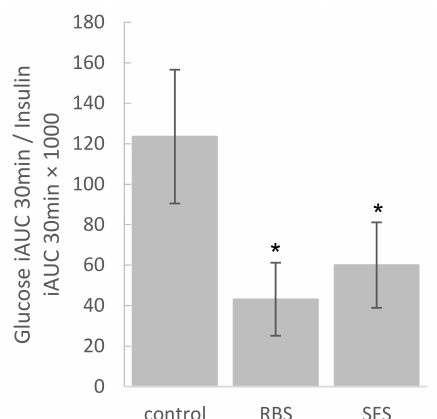
Figure 3. Ratio glucose/insulin during first 30 min for the reference and test foods. * ( p < 0.05) different from the control. RBS: rice bran soymilk, SFS: sugar-free